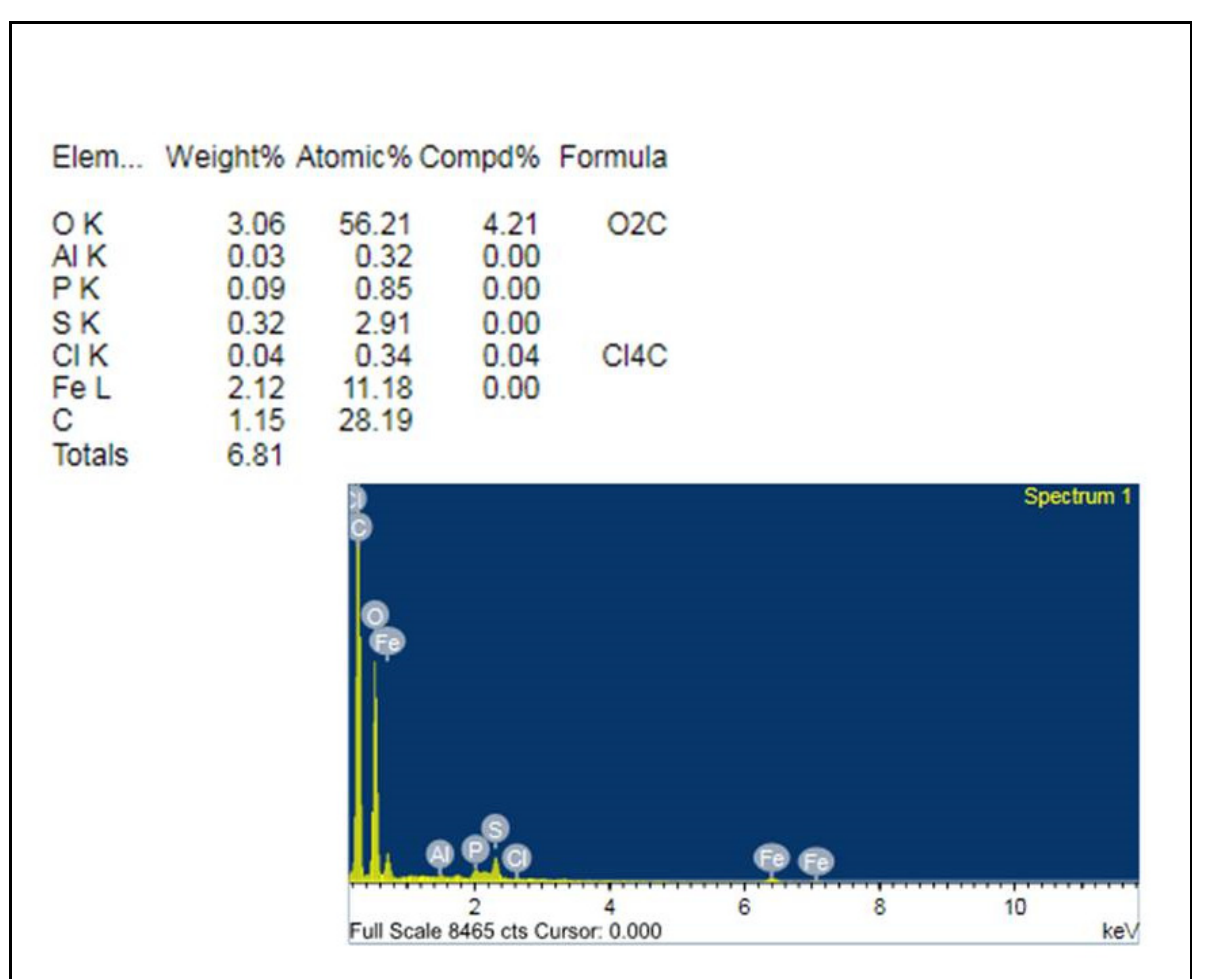
Figure 2. SEM images of spherical-shaped FeNPs.